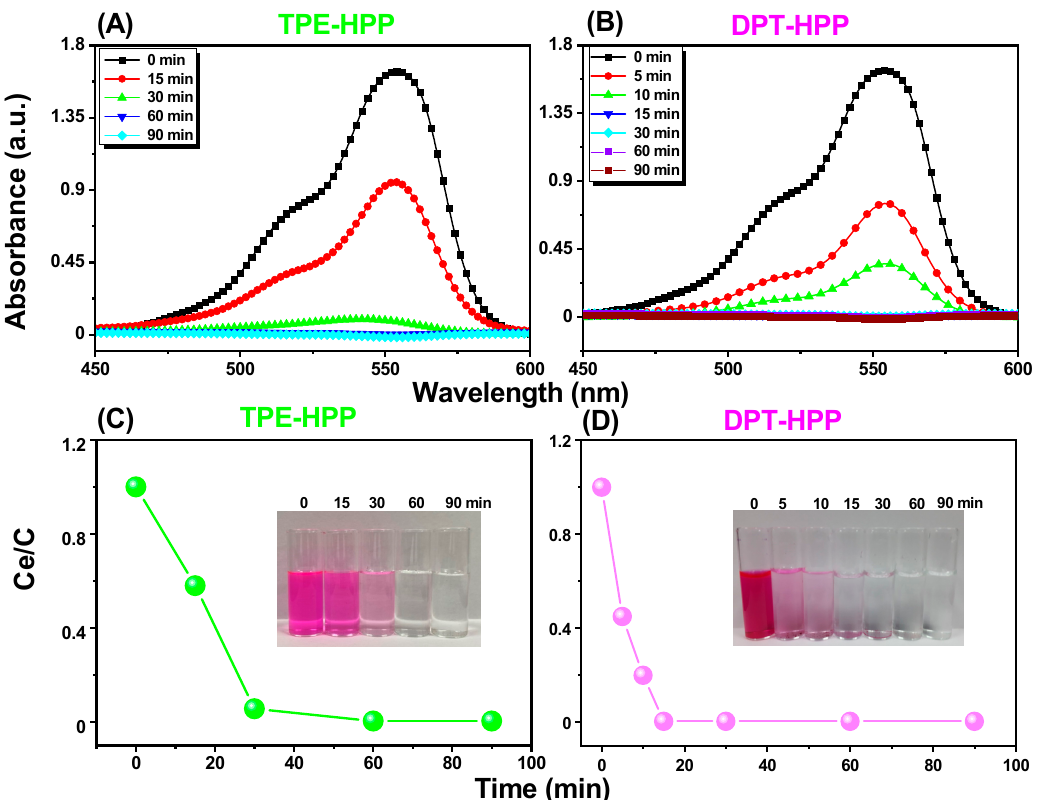
Figure 7. CO 2 uptake of TPE-HPP and DPT-HPP at ( A ) 298 K and ( B ) 273 K.